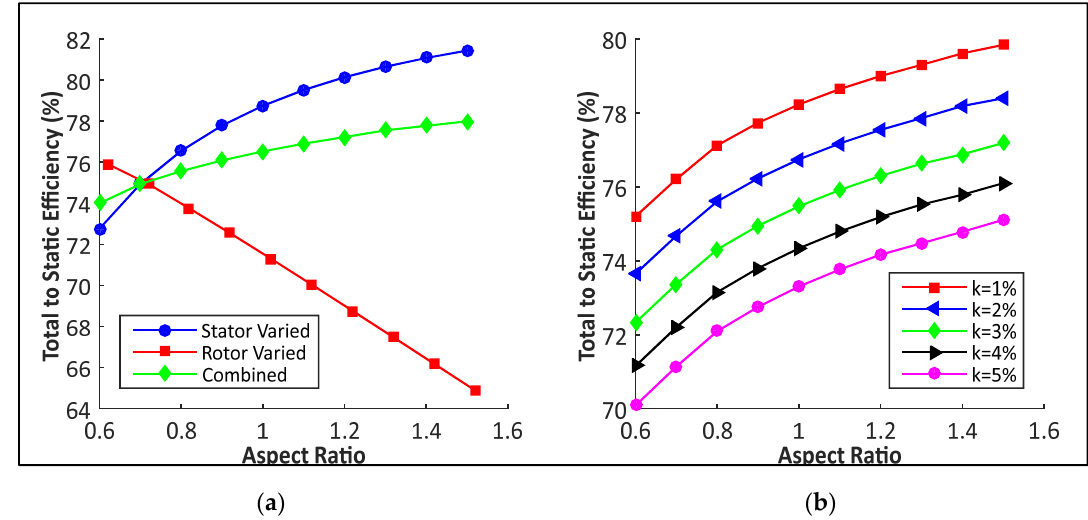
Figure 7. MATLAB predicted effect of aspect ratio for each blade row ( a ) and tip clearance ( b ) on turbine efficiency.